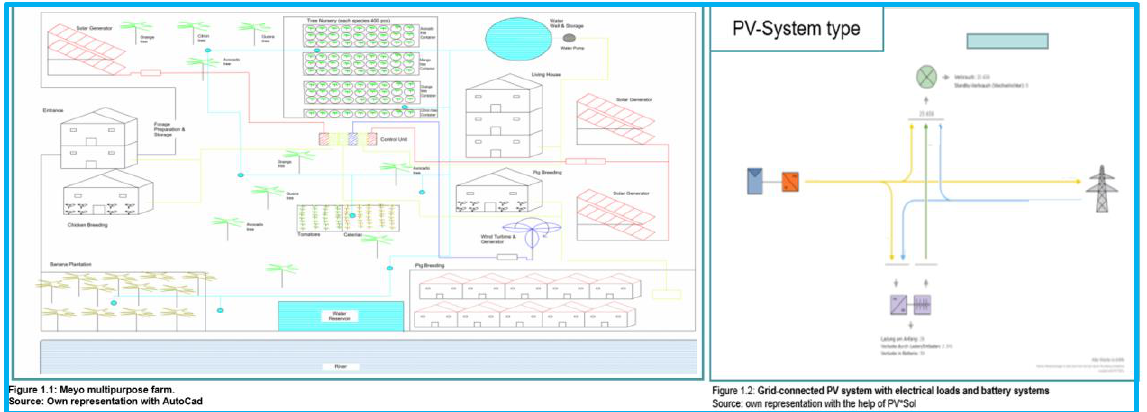
Figure 1. Meyo multipurpose farm and system type of solar generator.